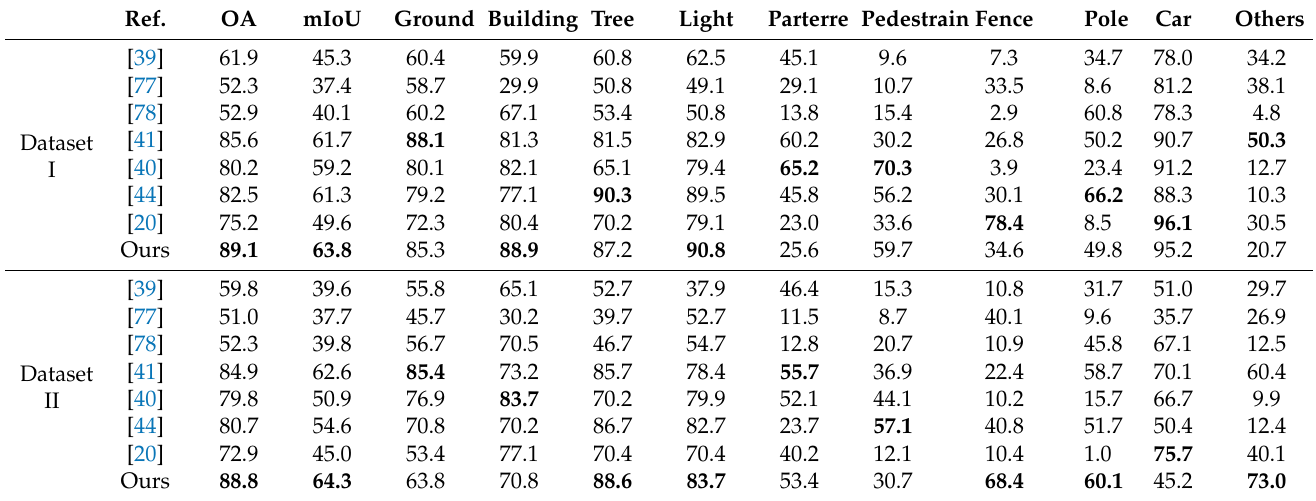
Table 1. Semantic segmentation quantitative evaluation (i.e., OA, mIoU and IoU of each class, all values in %) on Dataset I and Dataset II. Best results in